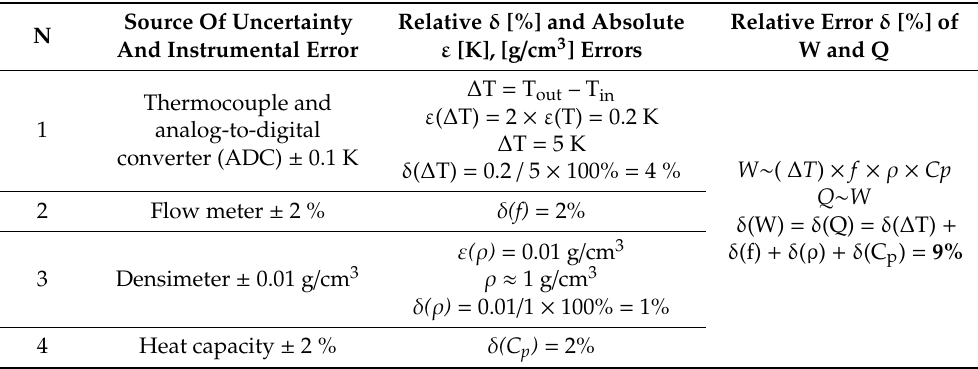
Table 2. The measurement uncertainties and error analysis.